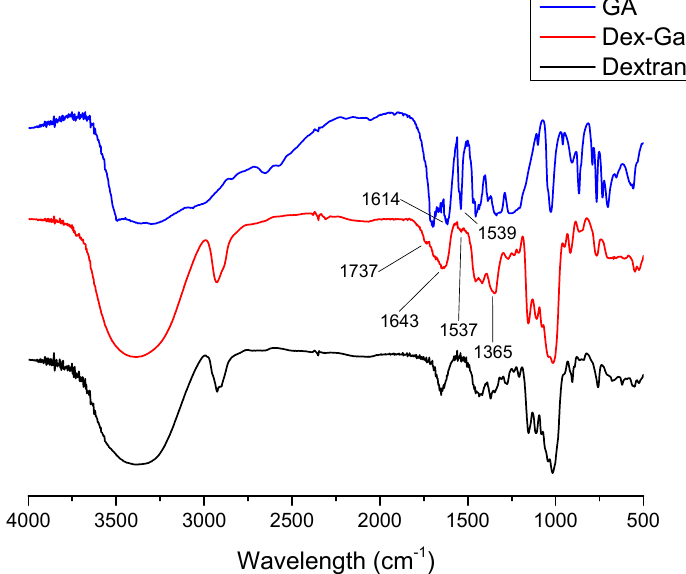
Figure 2. FTIR spectrum of dextran (black), GA (blue) and Dex − Gal (red).